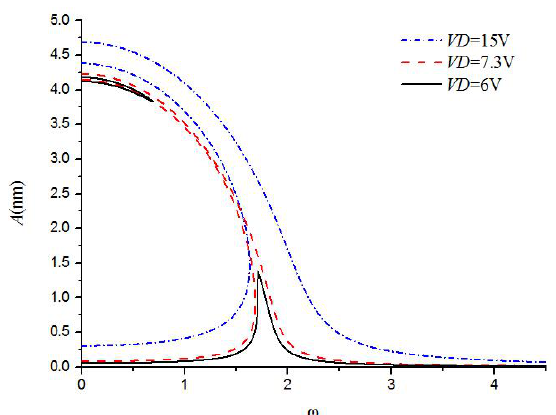
Fig. 5. The effect of load to the amplitude-frequency response